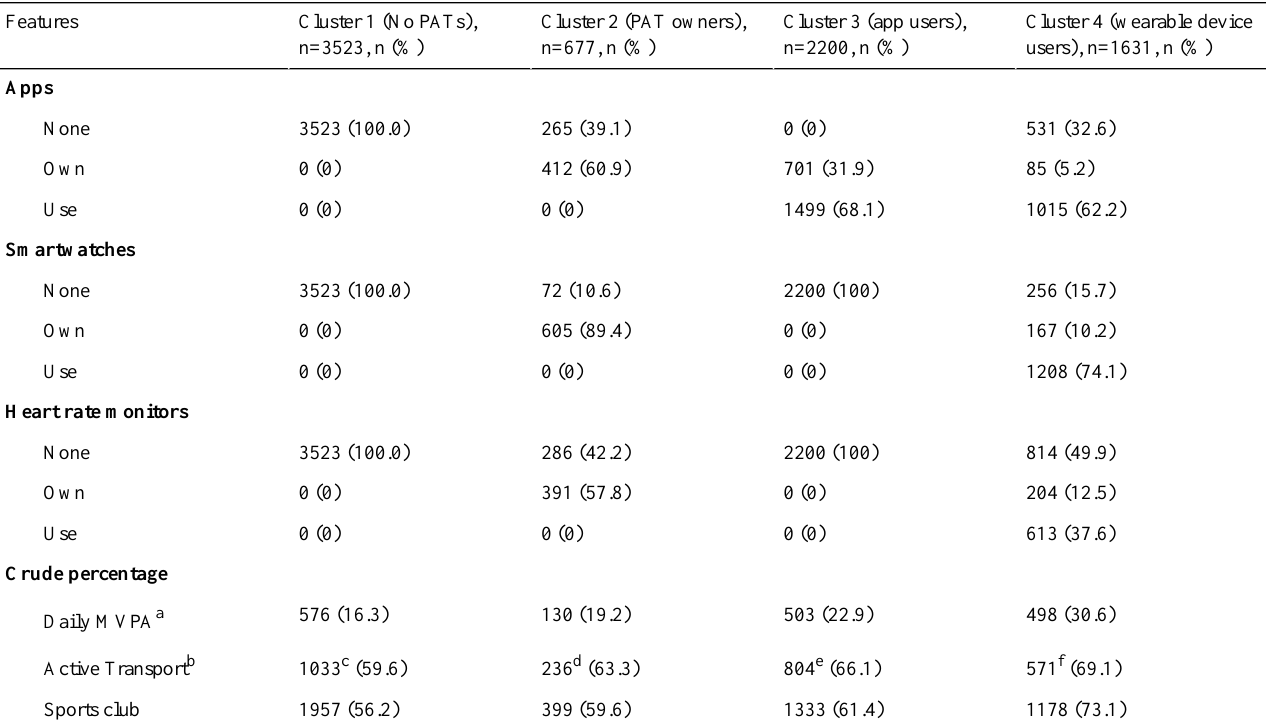
Table 2. Features of the four clusters from pooled data and crude estimates of the